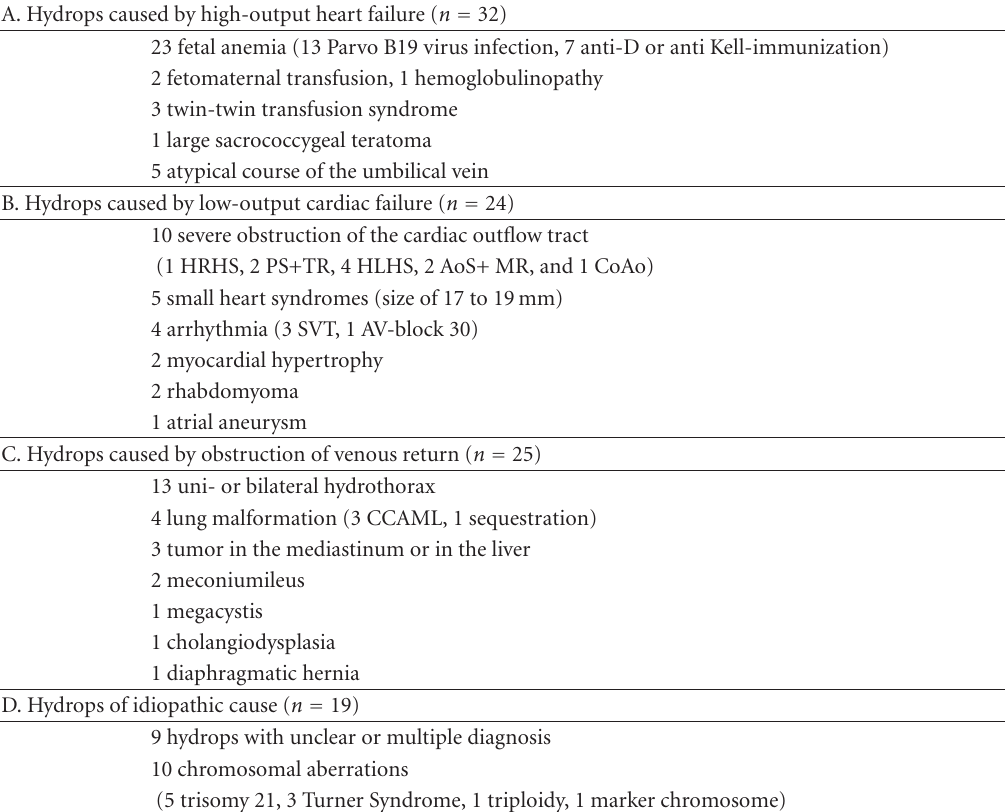
Table 1: Grouping of fetal hydrops by pathophysiological cause.